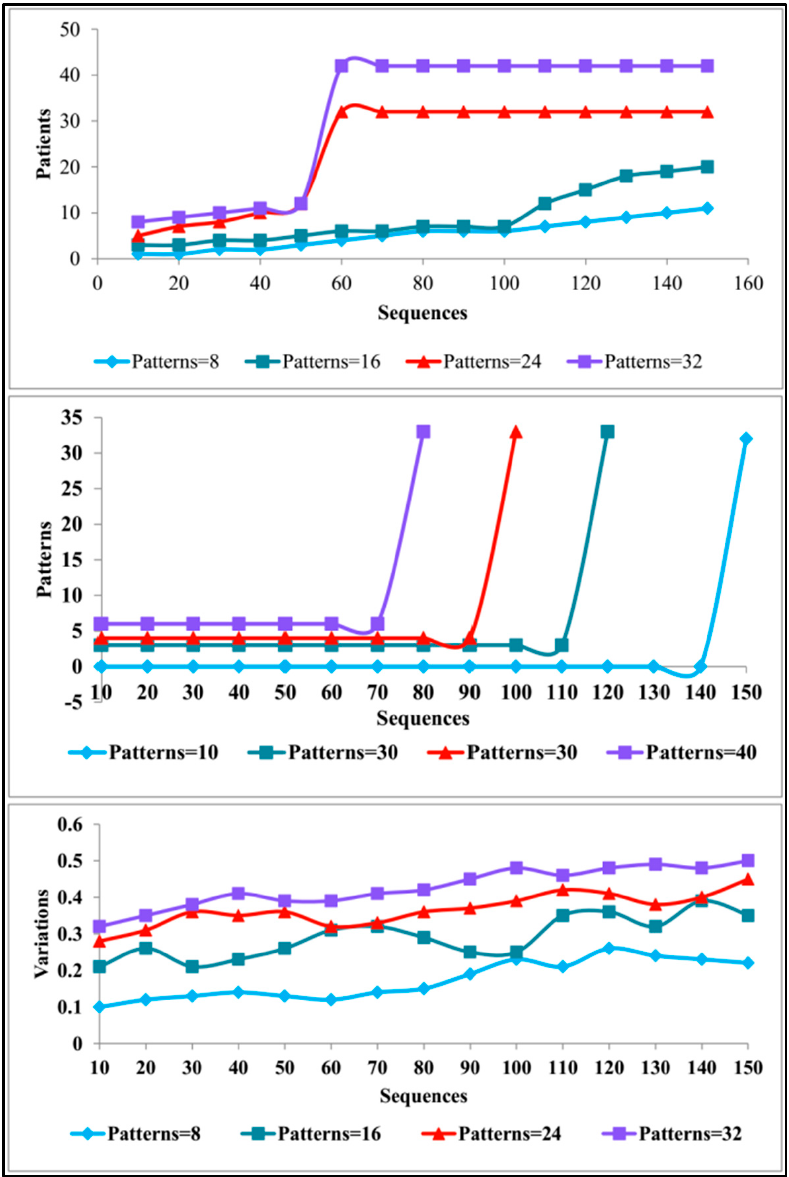
Figure 7. Observation analysis.